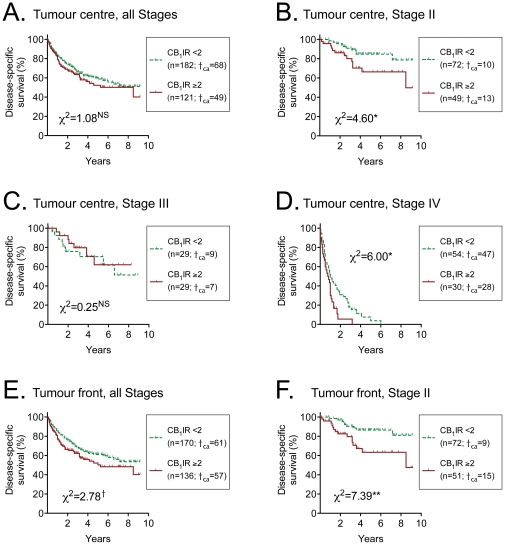
Influence of CB1IR scores at surgery upon disease-specific survival.Kaplan-Meier plots of the disease-specific survival for the tumour regions and disease stages shown. Shown in the figures are the number of cases (n) followed by the number who died as a result of the colorectal cancer (†ca). The χ2 value given in the figures is from the log-rank (Mantel- Cox) test comparing the two curves; **p<0.01, *p<0.05, †0.05<p<0.1; NSp>0.1. The corresponding χ2 values for tumour front stages III and IV were 0.24NS and 1.44NS, respectively.